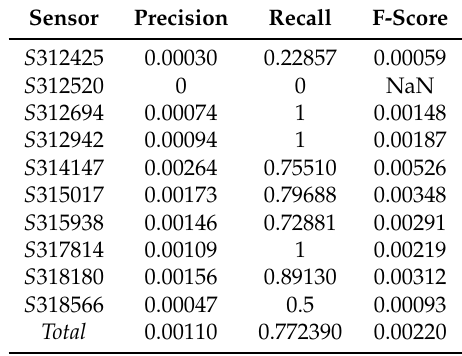
Table 6. Quality of fit for the Phase 1-Train data based on the thresholds determined by the labeled incidents using Algorithm